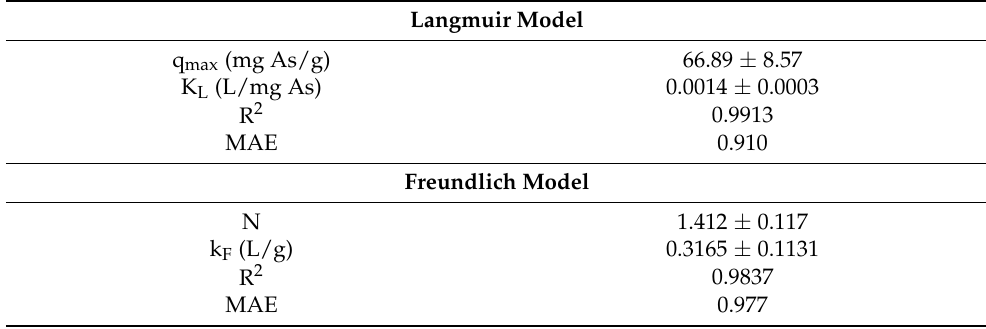
Figure 6. Arsenic adsorption onto ChM at 25 ◦ C and initial pH of 7.0; experimental adsorption isotherm ( λ ) and predicted data by Langmuir model (—) and Freundlich model (—). Table 2. Langmuir and Freundlich model constants and their correlation coefficients and MAE in As adsorption on ChM hydrogel beads at 25 ◦ C and initial pH = 7.0. Uptake capacity is expressed in As milligrams per gram of dry